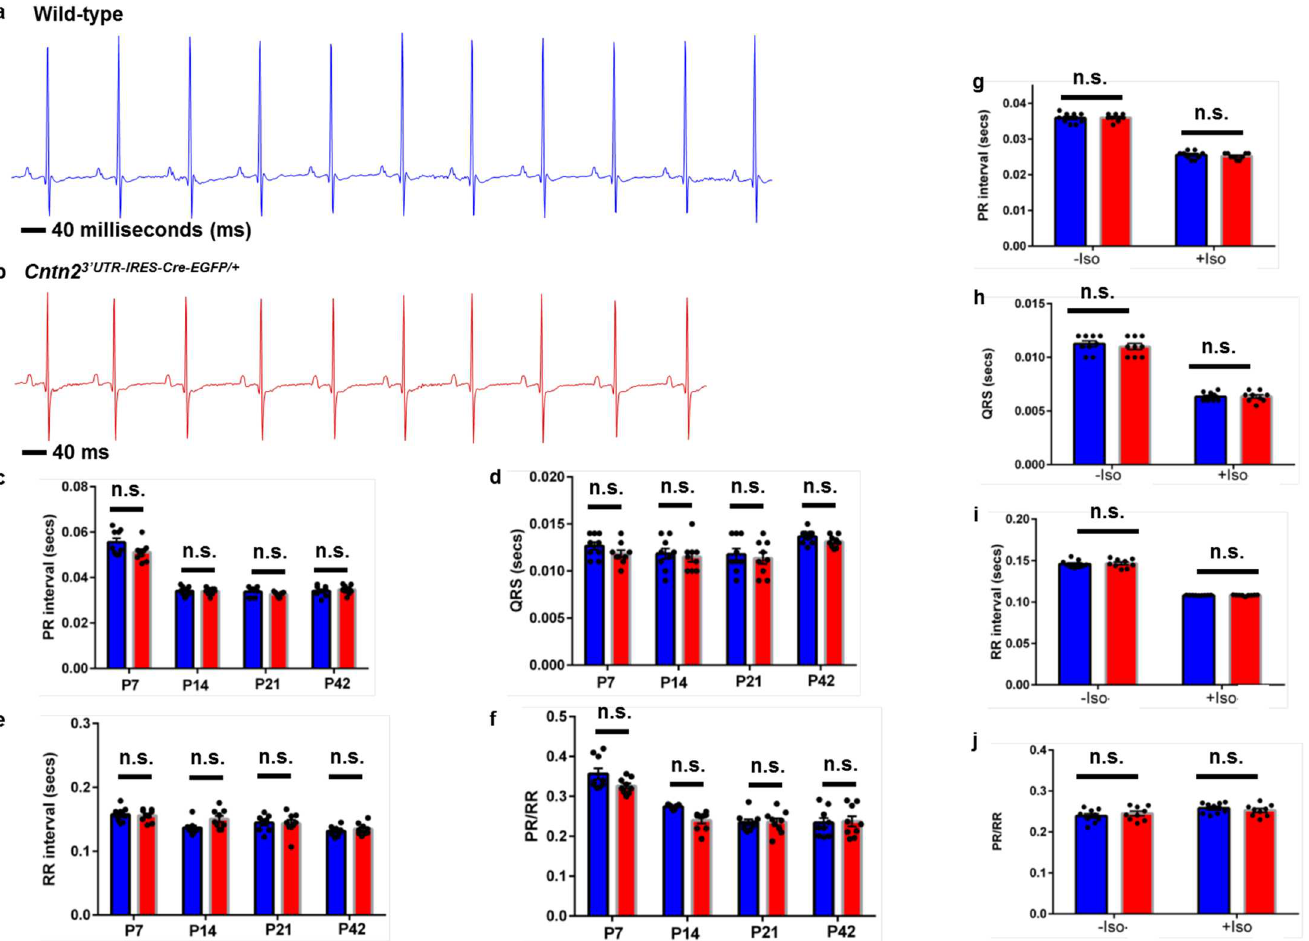
Fig 6. Cardiac electrical function is preservedin Cntn2 3’UTR-IRES-Cre-EGFP/+ mice. (a-j) Serial surface lead II ECGs were recordedon both groupsof mice (n = 9 per group) under mild anesthesiaat P7, P14, P21, P28, and P42. ExemplaryECG traces for P42 (a) WT and (b) Cntn2 3’UTR-IRES-Cre-EGFP/+ mice are shown. Scale size: 40 milliseconds (ms). (c) PR interval (in seconds), (d) QRS width (in seconds), (e) RR interval (in seconds), and (f) PR/RR ratio were measuredat P7, P14, P21, and P42. At P28, (g) PR interval (in seconds), (h) QRS width (in seconds), (i) RR interval(in seconds), and (j) PR/ RR ratio were measuredpre- and post-isoproterenol (-/+ Iso) injection. Black circles representindividualWT and Cntn2 3’UTR-IRES-Cre-EGFP/+ mice used in this study. Blue and red bars representmean values for each parameter in WT and Cntn2 3’UTR-IRES-Cre-EGFP/+ mice, respectively. No statistically significantdifferences were observedbetweengroups. ns, not